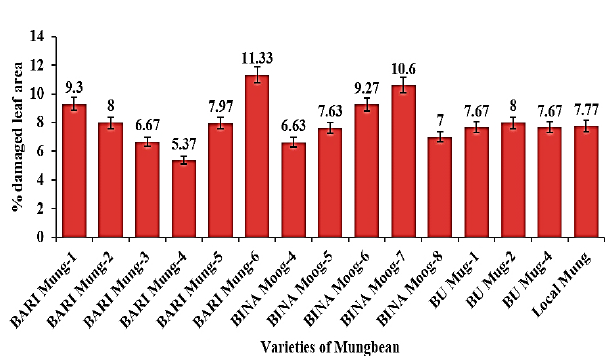
Figure 1: Percentage of damaged leaf area in different varieties of mungbean